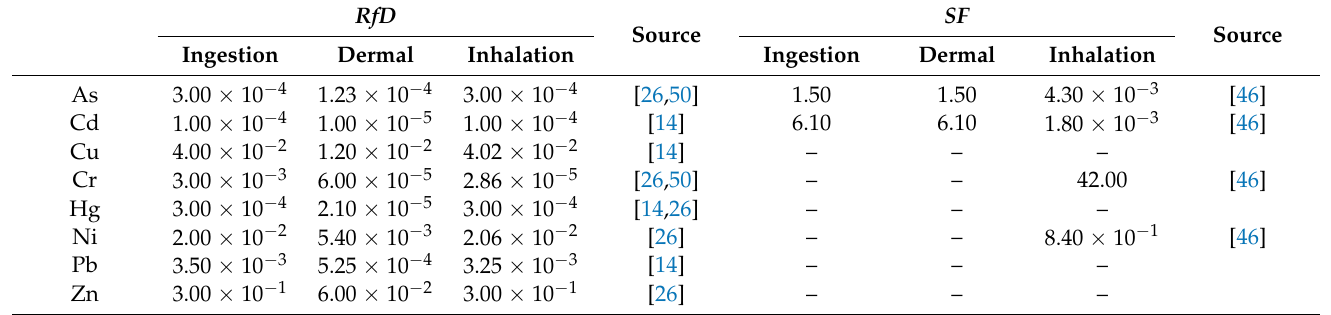
Table 2. Reference doses ( RfDs ) for non-carcinogenic metals and slope factors ( SFs ) for carcinogenic metals (mg kg − 1